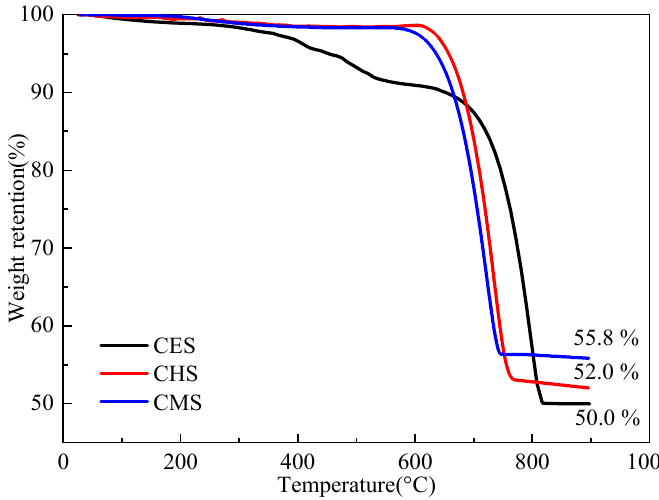
Figure 4. TG curves of shell bio-fillers.